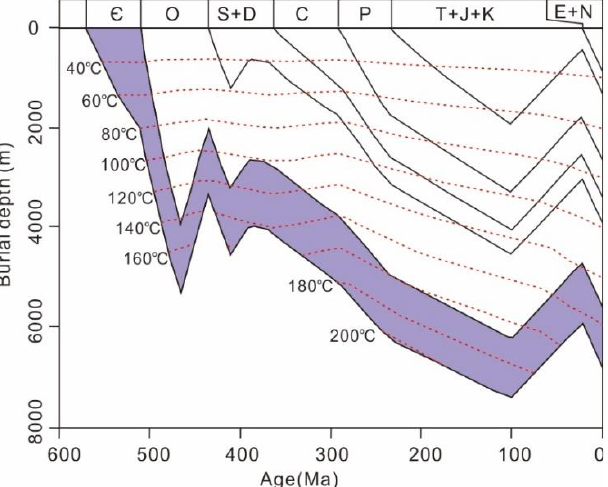
Figure 2. Burial history of the Cambrian succession in the Bachu area based on well HT1 (modified from Qiu et al. (2012) [32]).